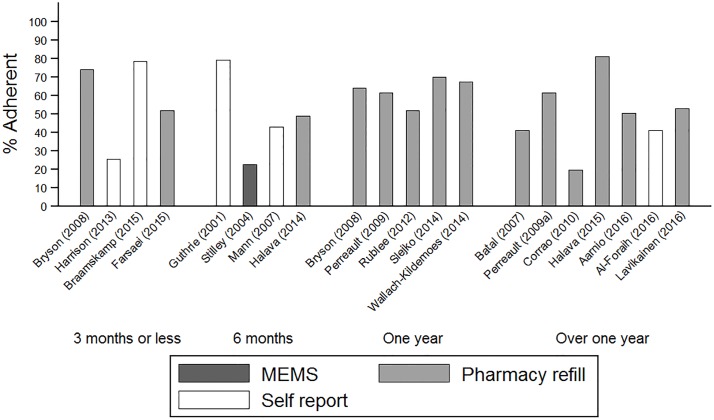
Percentage of patients adherent to statins grouped by follow-up and adherence measure.MEMS; Medcation event monitoring system, Pharmacy refill; medication possession ratio (MPR) or Proportion of days covered (PDC).